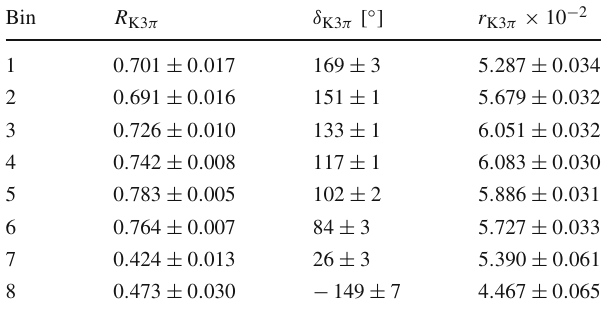
Table 11 Coherence factor and average strong-phase differences in regionsofphasespace.Thespreadofcoherencefactors,averagestrong- phase difference and ratio of amplitudes from choice of WS model characterised with the RMS of the distribution Bin R K3 π δ K3 π [ ◦